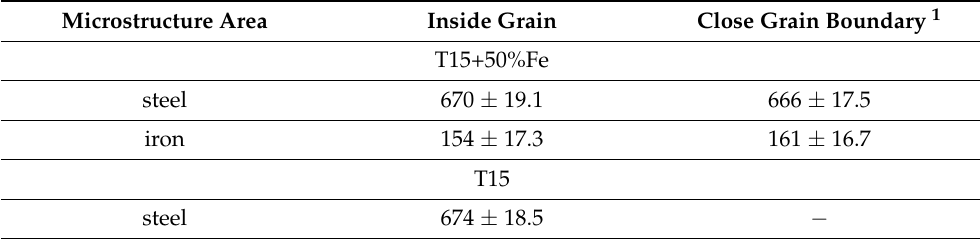
Table 2. Microhardness (HV0.01) of spark plasma sintered T15 and T15+50%Fe